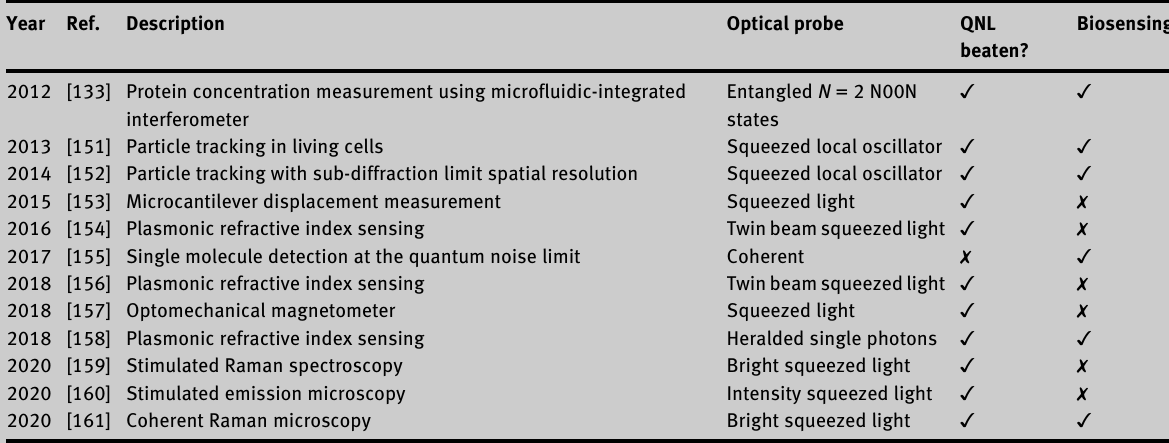
Table  : Comparison of quantum-enhanced sensing experiments with potential applications in biosensing. Year